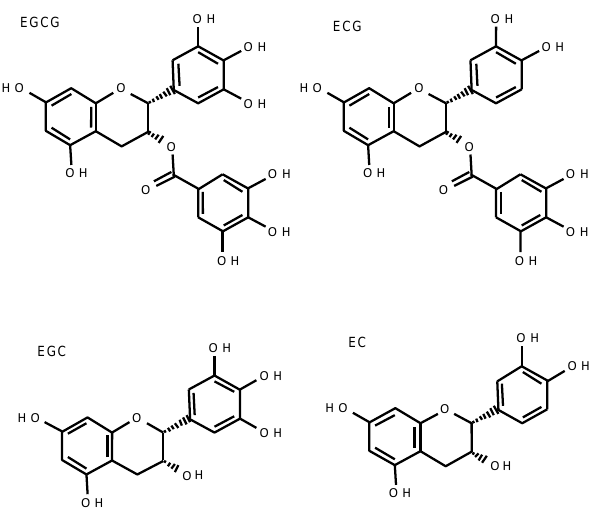
Figure 1. The structure of green tea catechins.